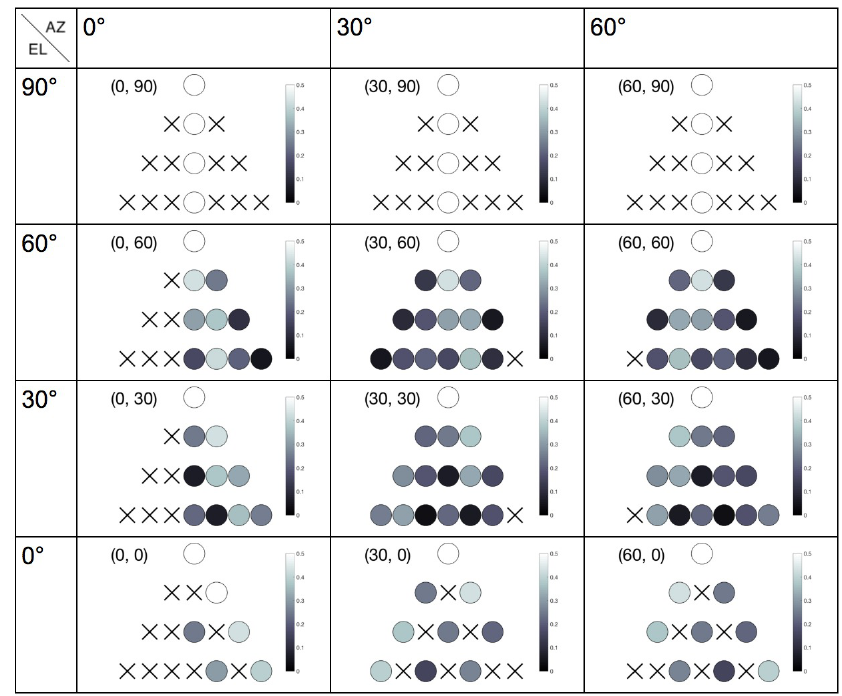
Figure 9. Channel occupancy of B-format Ambisonics audio as a function of azimuth (AZ) and elevation (EL) of sound sources. Empty channels are represented here with the ‘x’ sign.